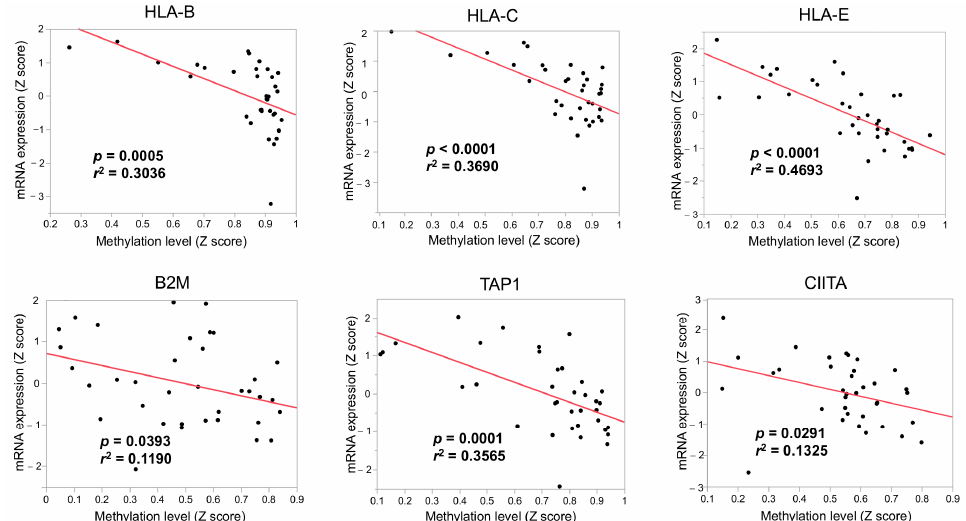
Figure 2. Correlation between methylation level and expression of the genes involved in antigen- presenting machineries. Negative correlations are observed between expression and methylation levels in HLA-B, HLA-C, HLA-E, B2M, TAP1, and CIITA. Pearson’s correlation coefficients are shown for each correlation.